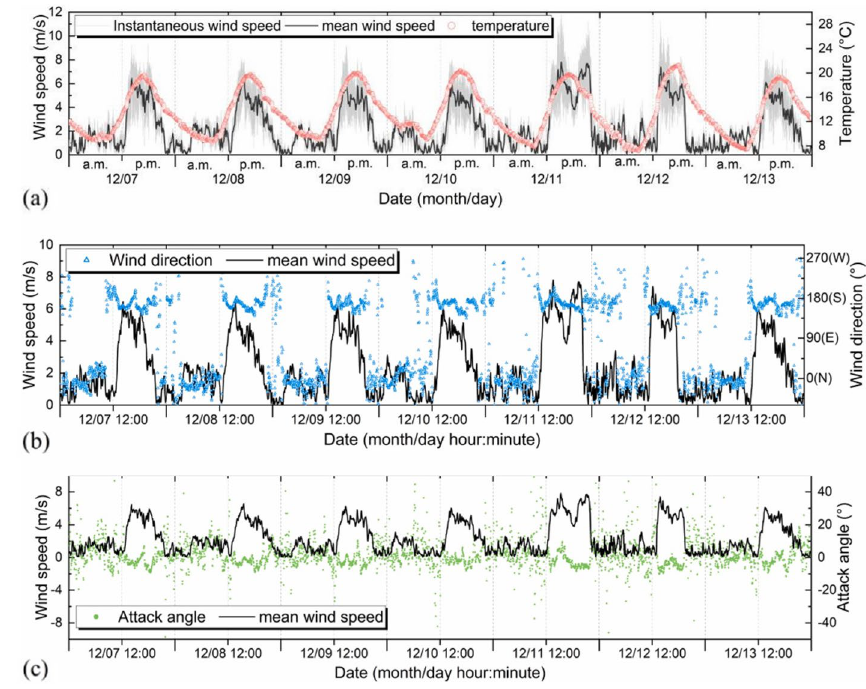
Fig. 1 Typical time history of wind speed in mountain areas (Li et al.